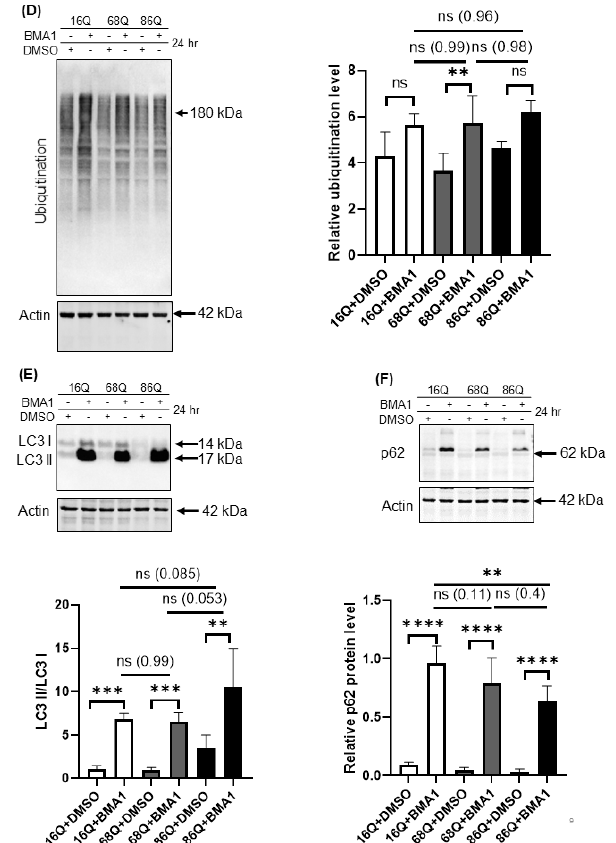
Figure 6. Proteolytic activity and ubiquitination in HD and healthy fibroblasts. ( A ) Proteasome complex activity were analyzed by 3–8% native gel electrophoresis in both healthy and HD fibroblasts. Cells were incubated in the presence and absence of 10 µ M MG132 proteasome inhibitor and were assayed with the fluorogenic Suc-LLVY-AMC proteasome substrate (upper panel). The activity of the proteasome in juvenile HD fibroblasts was normalized to healthy control. Data represent the mean ± SD, n = 3 independent experiments (lower panel). ( B ) Whole cell lysates (50 µ g total protein) were loaded onto SDS-PAGE and transferred to nitrocellulose membrane for Western blot analyses to assess proteasome protein level in the presence and absence of 10 µ M MG132 using an antibody for the proteasome core β 1 subunit. Actin was used as an internal loading control (upper panel). Quantification of proteasome β 1 subunit was performed from three independent experiments. Protein levels in HD fibroblasts were normalized to healthy control. Data represent the mean ± SD, n = 3 independent experiments (lower panel). ( C ) Whole cell lysates (10 µ g total protein) were loaded onto SDS-PAGE and transferred to nitrocellulose membrane for Western blot analyses to assess ubiquitination in the presence and absence of 10 µ M MG132. Actin was used as a loading control (upper panel). Protein levels in HD fibroblasts were compared to healthy control. Data represent the mean ± SD, n = 3 independent experiments (lower panel). ( D ) Whole cell lysates (10 µ g total protein) were loaded onto SDS-PAGE and transferred to nitrocellulose membrane for Western blot analyses to assess ubiquitination in the presence and absence of 100 nM Bafilomycin 1 (BMA1). Actin was used as a loading control (upper panel). Protein levels in juvenile HD fibroblasts were compared to healthy control. Data represent the mean ± SD, n = 3 independent experiments (lower panel). ( E , F ) Western blot analyses of autophagy markers LC3I, LC3 II and p62 in healthy and HD fibroblasts. Whole cell lysates (20 µ g total protein) were loaded onto SDS-PAGE and transferred to nitrocellulose membrane for Western blot analyses to assess autophagy activity in the presence and absence of 100 nM Bafilomycin 1 (BMA1). Actin was used as a loading control (upper panels). Protein levels in HD fibroblasts were compared to healthy control. Data represent the mean ± SD, n = 3 independent experiments (lower panels). (* p < 0.05; ** p < 0.01, *** p < 0.001 **** p <